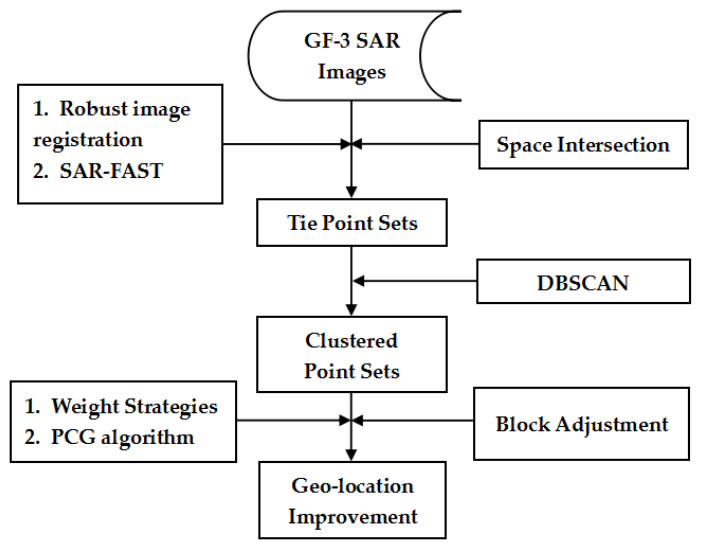
Figure 2. Flow chart of our proposed